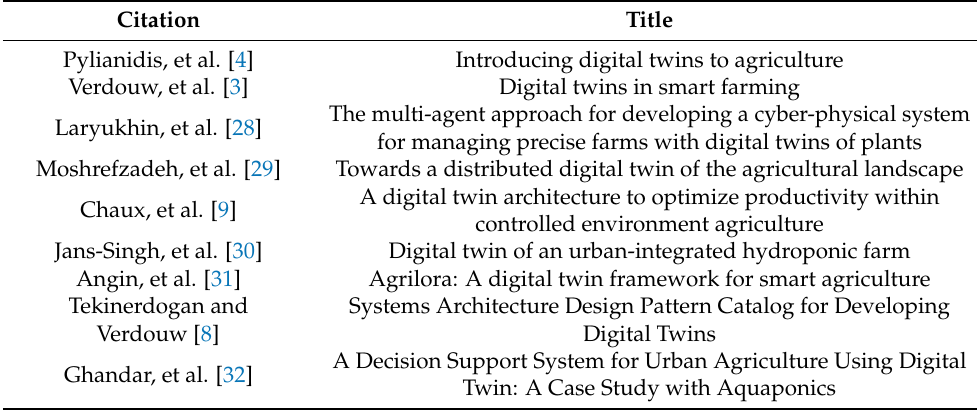
Figure 2. Quality score distribution of the selected articles. Table 6. Selected Articles for Review.